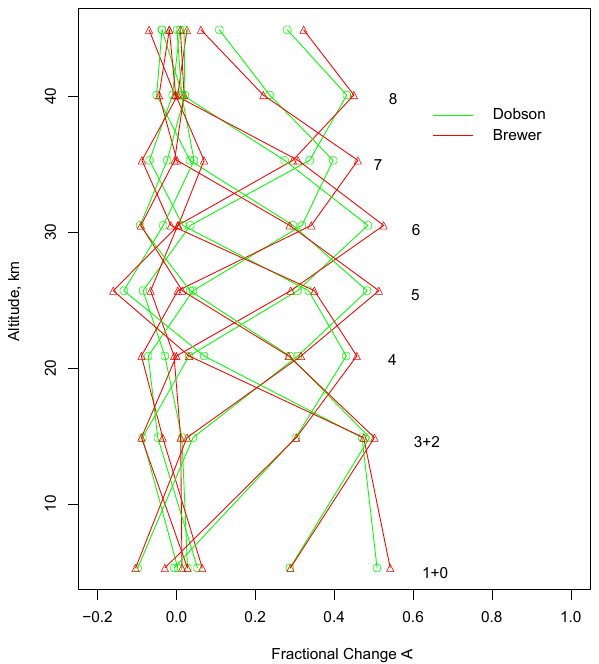
Fig. 2. Averaging kernels for Dobson (green) and Brewer (red) are shown as fractional change vs. altitude. Corresponding Umkehr lay- ers are indicated at the maximum of the